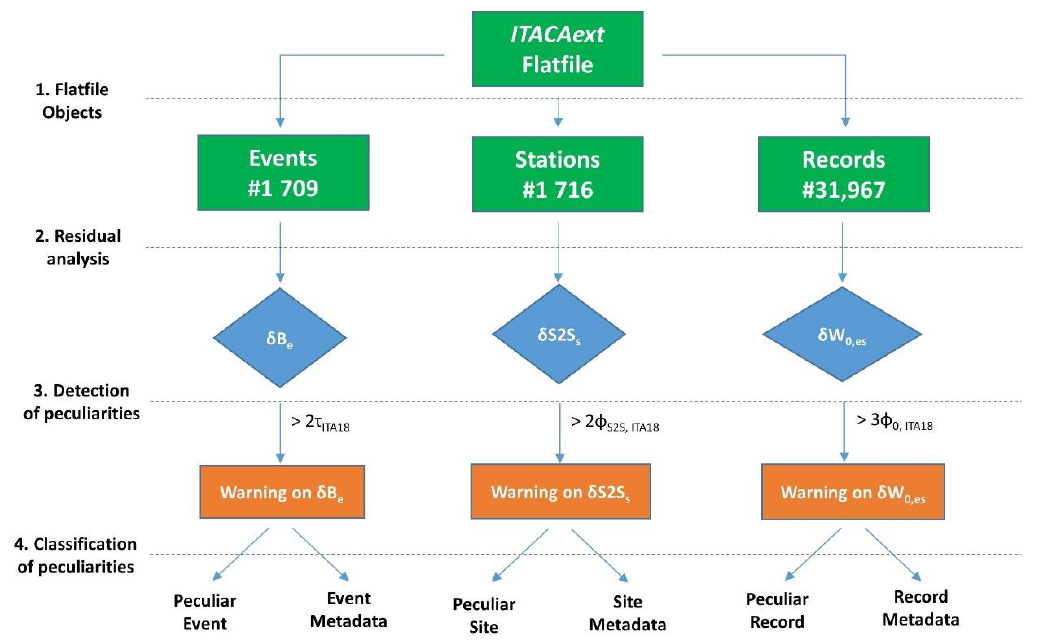
Figure 5. workflow for the consistency check of the ITACAext flatfile. Figure 5. Workflow for the consistency check of the ITACAext